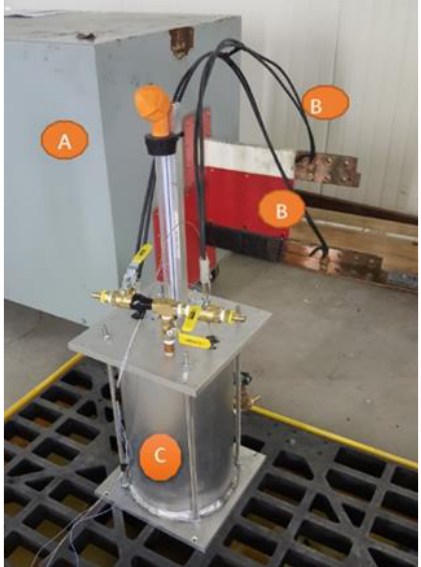
Figure 9. Experimental transformer connection to the high current source. (A) High current source CIGELE-S5000A, (B) Connection cables, (C) Laboratory transformer.